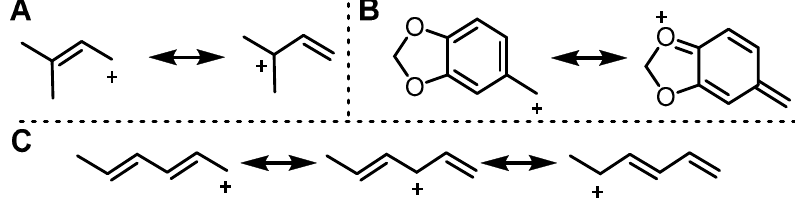
Figure 4. Depiction of the resonance stabilization of representative alkyl ‐ PP donors ( A ) 2 , ( B ) 58 , and ( C ) 16.